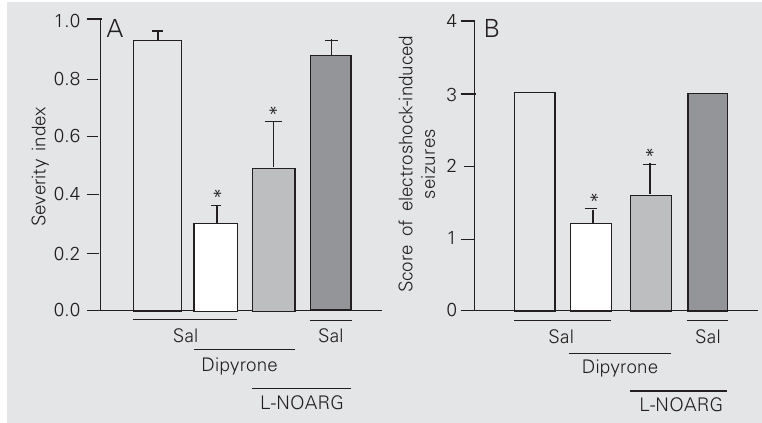
Figure 3. Effect of acute administration of N ω -nitro-L-arginine (L-NOARG) on the anticonvul- sant action of dipyrone in audiogenic seizures (A) and electroshock (B). L-NOARG (120 mg/kg, ip ) administered 5 min before dipyrone did not reverse the anticonvulsant effect of dipyrone (300 mg/kg, ip ). Data are reported as mean ± SEM severity index or electroshock score (N = 5-6). *P < 0.05 compared to the saline (Sal)-treated group (ANOVA + Bonferroni's